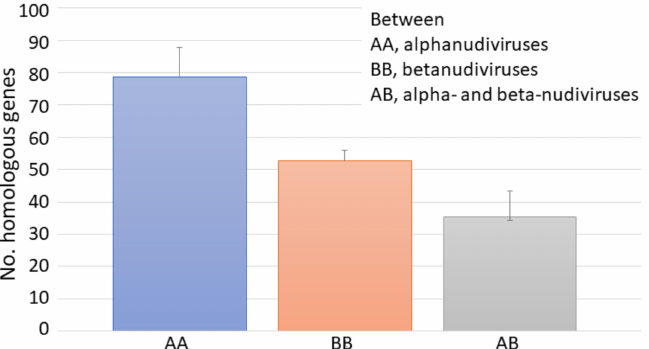
Figure 5. Numbers of homologous proteins among nudiviruses as determined by BLASTp. The cutoff E -value for determination of homology was set at 0.0001. Bars represent SD of the